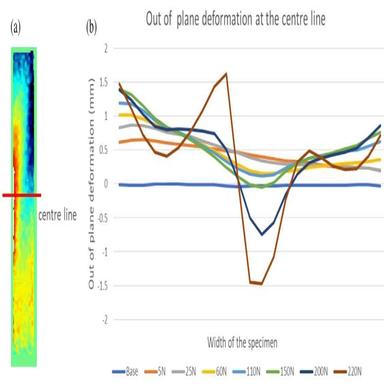
Out of plane deformation at the centre line for a representative IM7/8552 specimen—(a) mark of the centre line and (b) the out of plane deformation along the line. (For interpretation of the references to colour in this figure legend, the reader is referred to the web version of this article.)